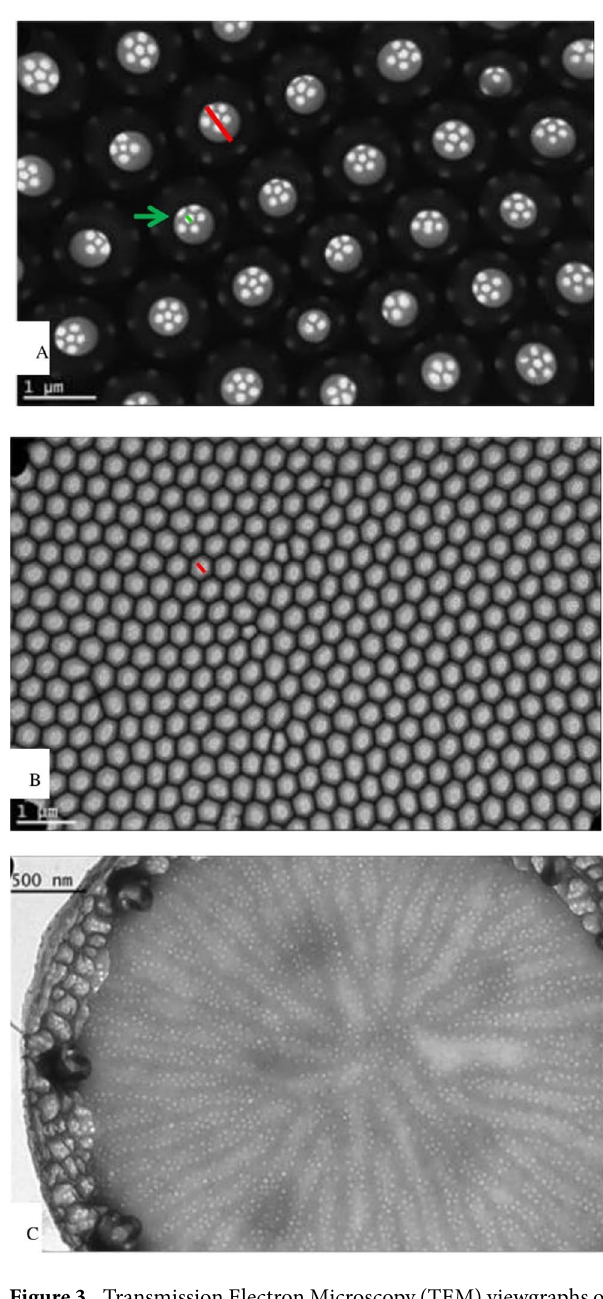
Figure 3. Transmission Electron Microscopy (TEM) viewgraphs of ( A ) C. granii , ( B ) T. punctifera and ( C ) T. pseudonana .